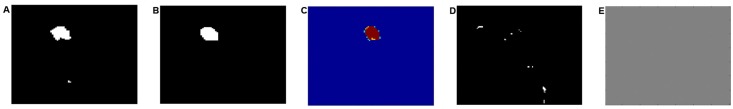
Illustration of a fibroadenoma (case II).(A)-(E) Segmented tumours using FCMs and the proposed hybrid classification, overlapping images, and depiction of noisy voxels from imaged fatty tissue, using both classification methods; absence of noisy voxels in E relate to results from the proposed algorithm.